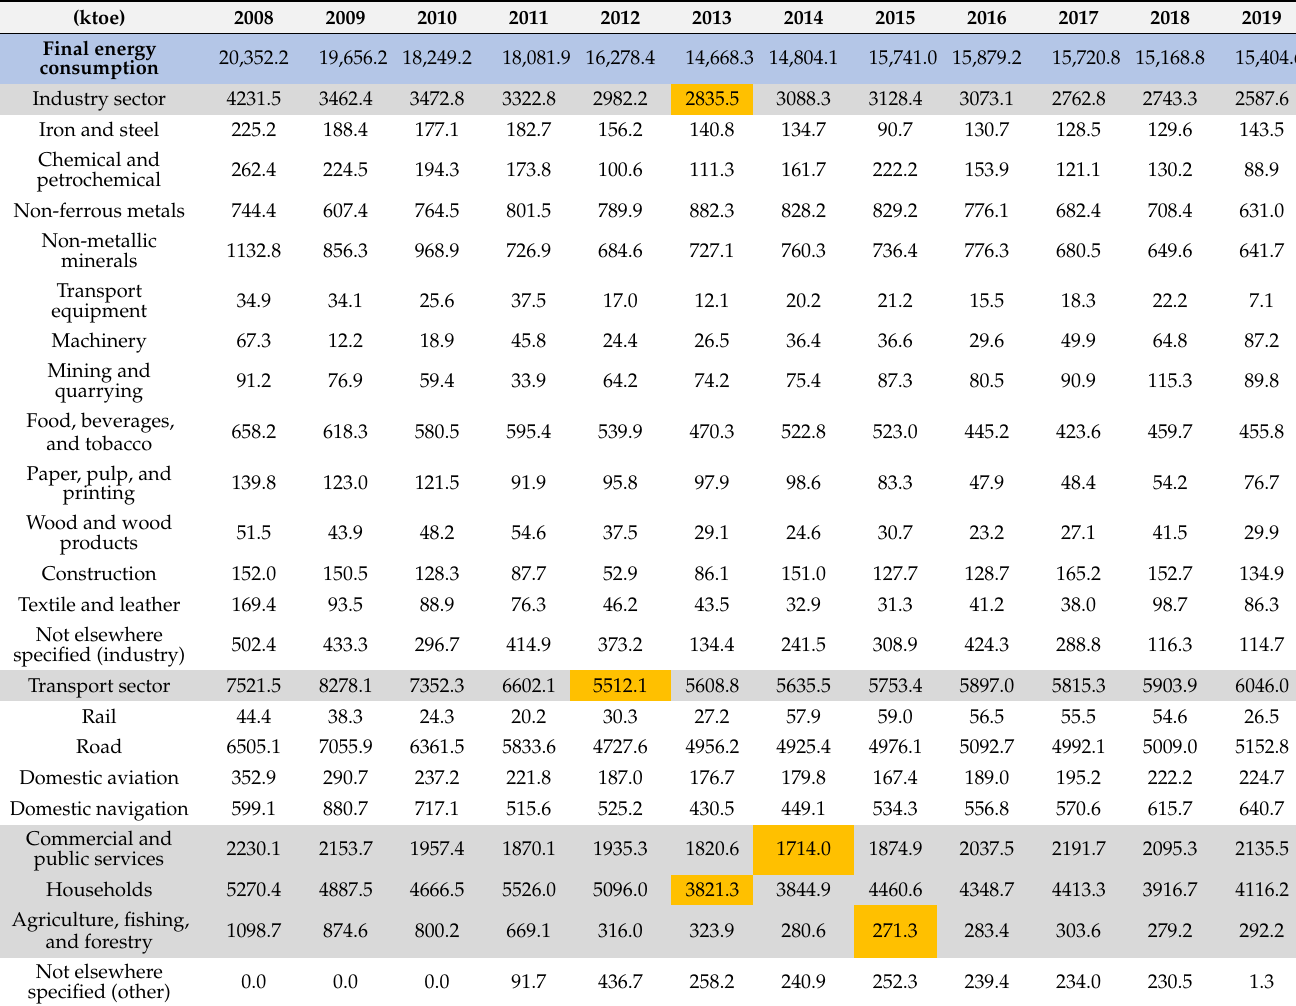
Table 2. Final energy